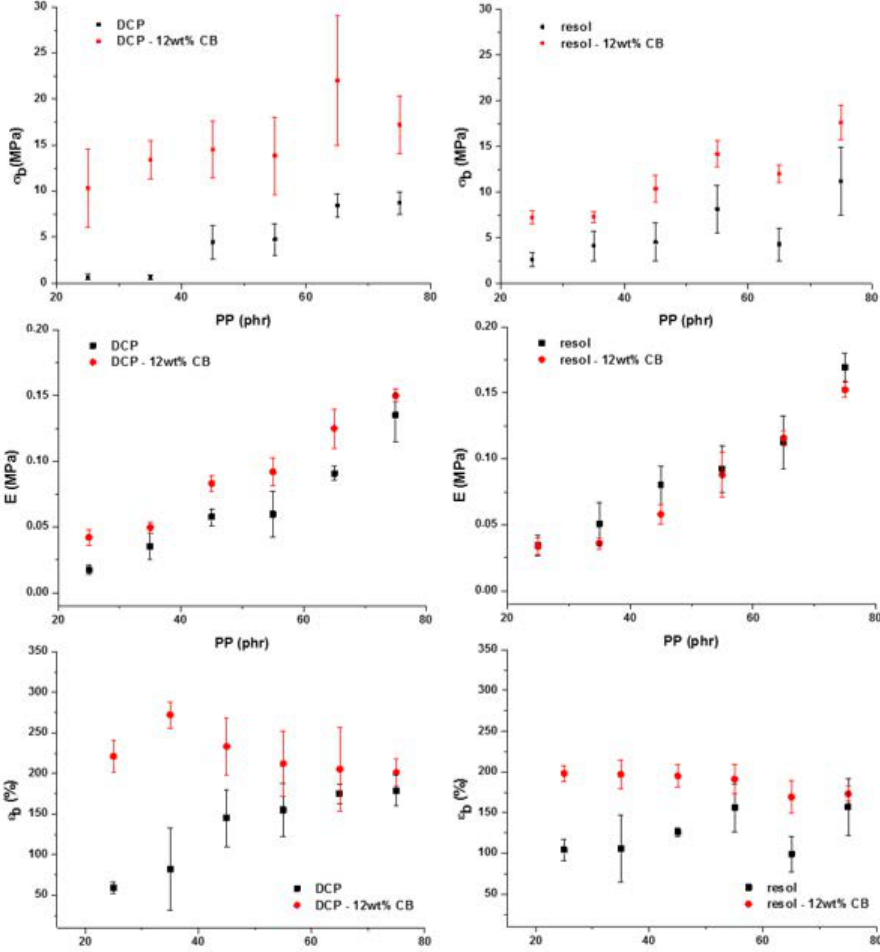
Figure 8. Evolution of the mechanical properties: tensile strength, Young modulus and elongation at break in function of the PP amount for unfilled and carbon black filled